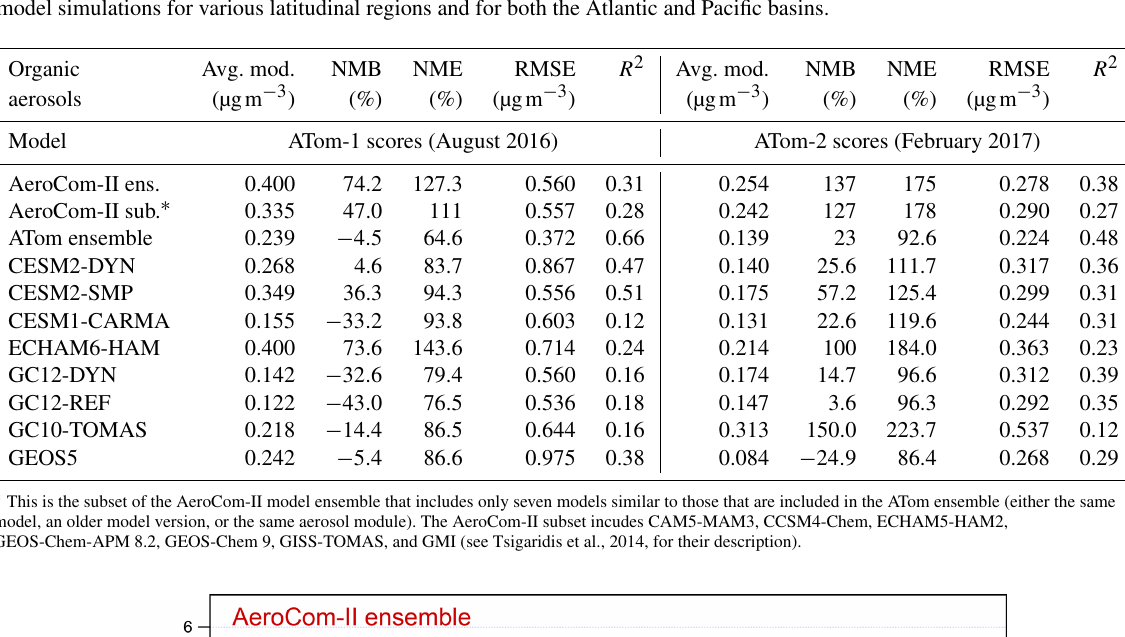
| (M i − O i ) | / (cid:80) O i , root mean square error (RMSE; i i